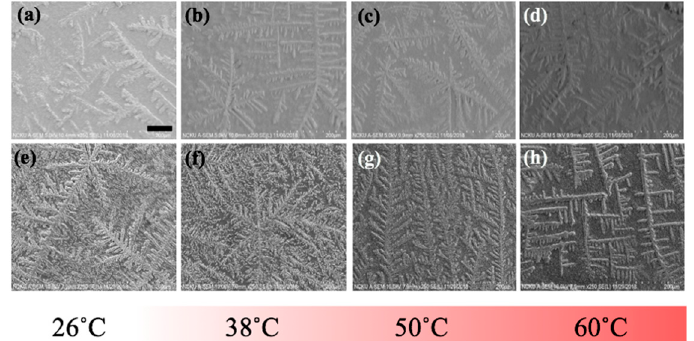
Figure 6. Stereoscopic images of the edges of ( a – f ) pure and ( g – l ) CsWO 3 NP-doped LAFs treated at various temperature. The scale bar shown in ( a ) is 1 mm, applicable to all images in this figure.